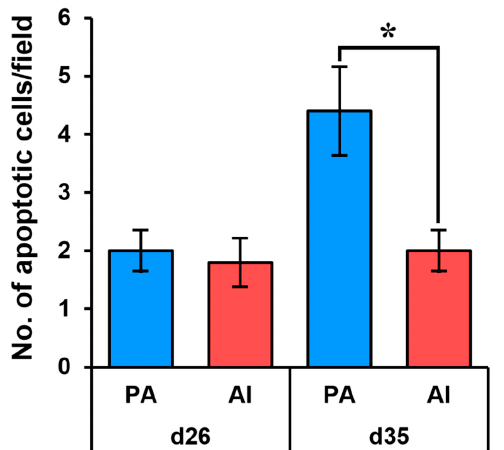
Figure 4. Histopathological analysis of PA and AI fetuses at day 35. Histopathological examination of developing livers ( a , b ), cartilage ( c , d ), and brains ( e , f ) were conducted on PA and AI fetuses at day 35 after embryo transfer. Black arrow indicates primitive hematopoietic cells in a liver section ( b’ ).